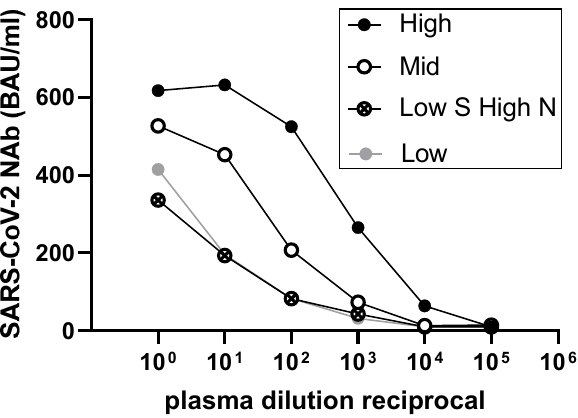
Figure 2. NIBSC standards display exceptional linearity when diluted and analysed via TRFIA. High, mid, low S high N, and low NIBSC standards were titrated in 10-fold steps and analysed for NAb using the PL-NAb test. Data are displayed as BAU/mL versus dilution and are represented by three independent determinations. Table 2. ELISA titration endpoints from binding assay of NIBSC standard plasma (left column) to SARS-CoV-2 S and N proteins. Plasma was diluted until endpoint binding was achieved. Titres are shown as the first dilution of IgG and IgA to reach <0.2 OD450 nm. IgG Spike IgA Spike IgG Nucleocapsid IgA Nucleocapsid